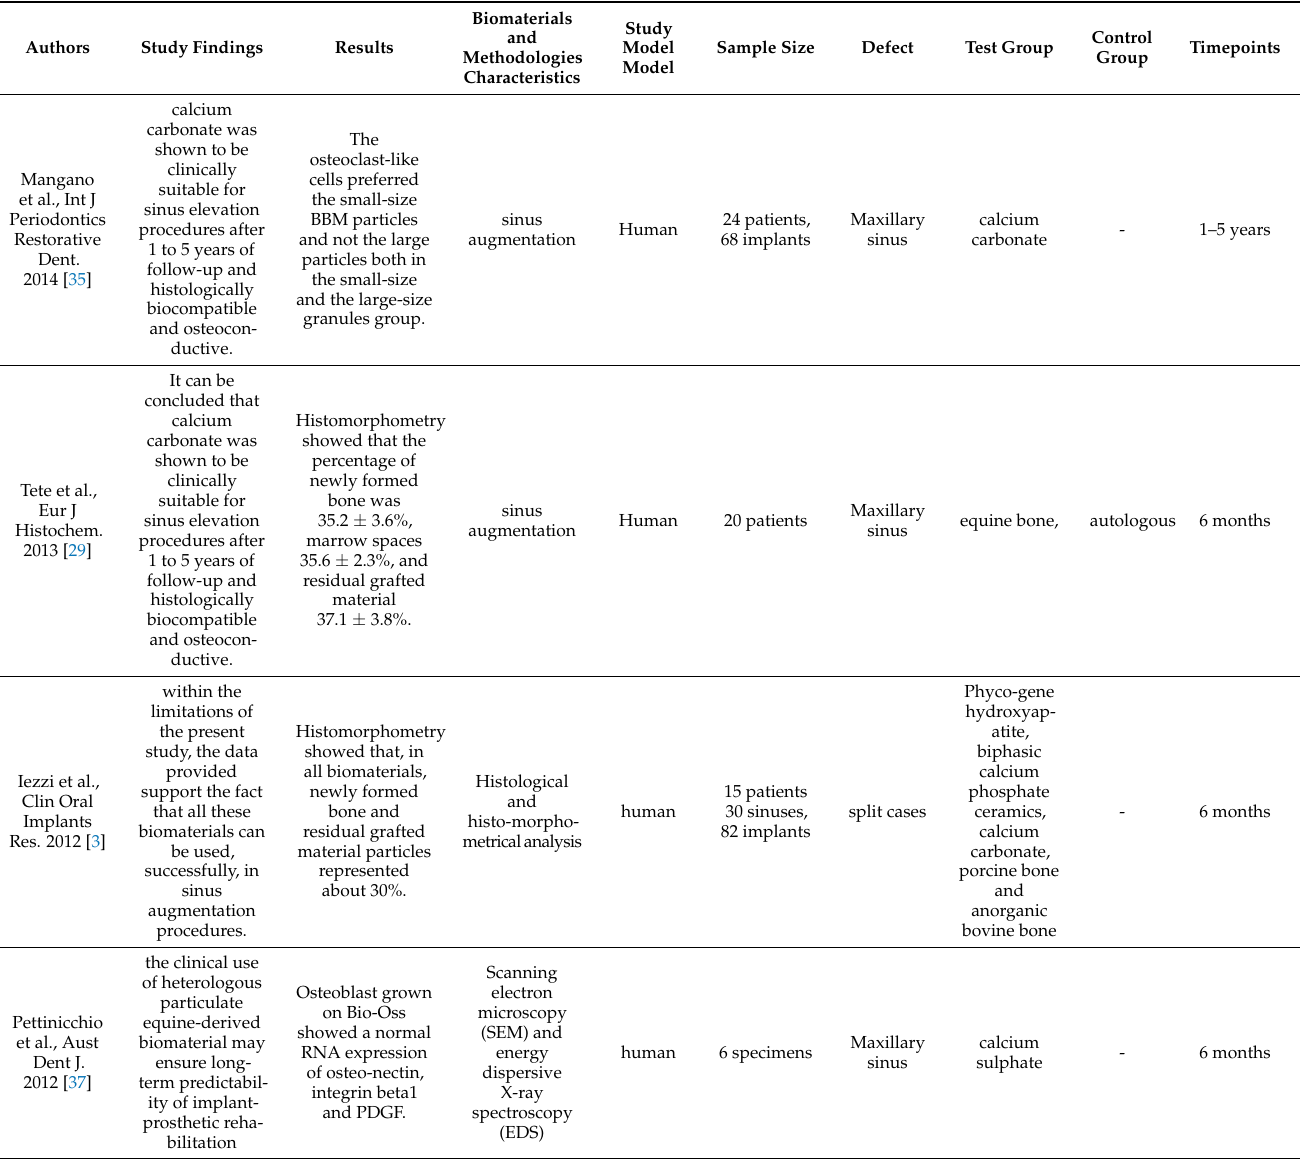
Table 5. Summary table of the Calcium carbonate findings of the papers